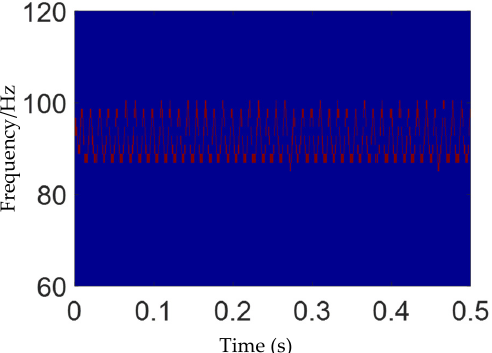
Figure 17. Time–frequency distribution obtained by the Figure 17. Time – frequency distribution obtained by the SET.